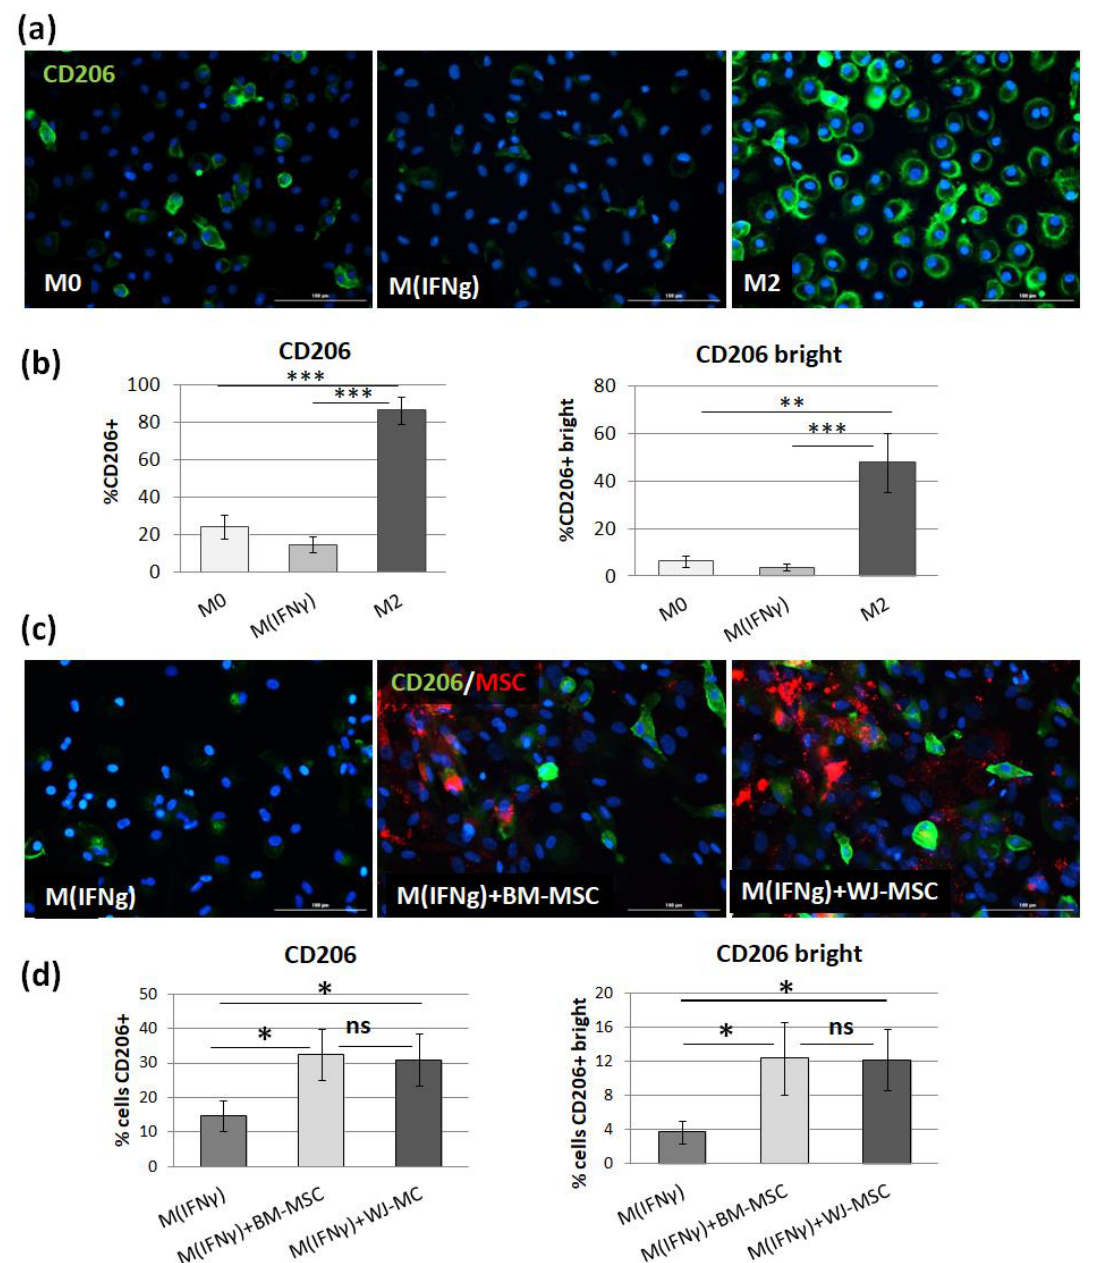
Figure 6. The effect of BM-MSCs and WJ-MSCs on the differentiation of macrophages into M2 phenotype. ( a ) Representative images illustrating the CD206 expression in unstimulated (M0), IFN γ -stimulated (M IFN γ ), and IL-4/IL-10 stimulated (M2) macrophages detected by immunocytochemistry assay using an anti-CD206 antibody. The signal was developed using green AF488-conjugated secondary antibody, and nuclei were counterstained with DAPI (blue). The scale bars in- dicate 100 m. ( b ) Bar graphs (mean ± SEM) represent the quantitative analysis of CD206 expression in different macro- phage subpopulations as a percentage of all cells. Data collected from four experiments performed in duplicates with two